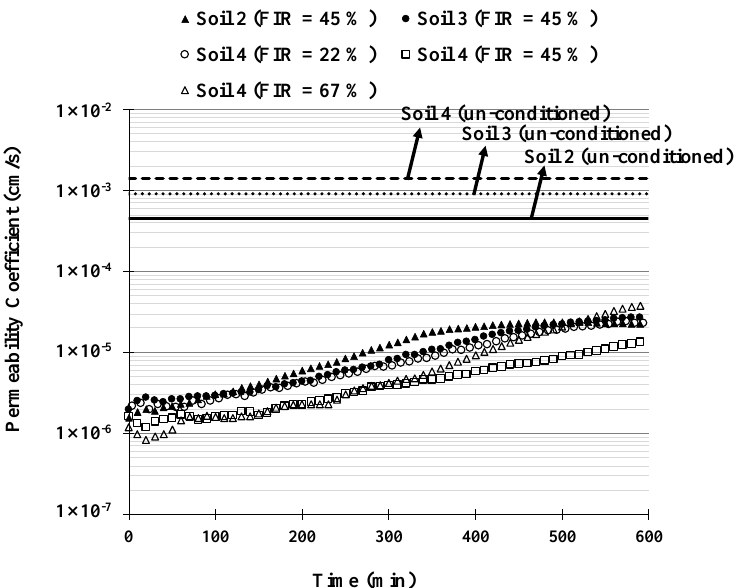
upper bound shown in Figure 5. In these tests, all the soil samples were conditioned with foam added at a minimum FIR of 22% and with and without adding the water-absorbing polymer; typical results are shown in Figure 7.